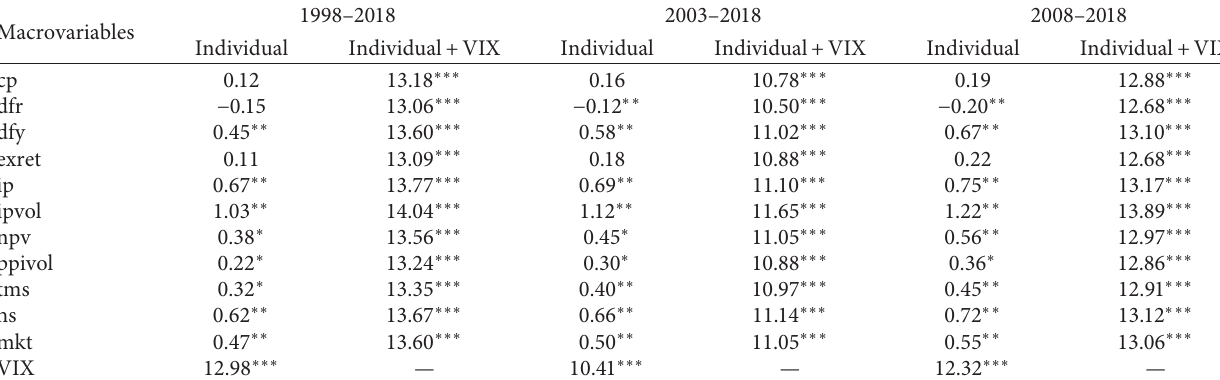
Table 7: Out-of-sample forecasting results with different macroinformation.